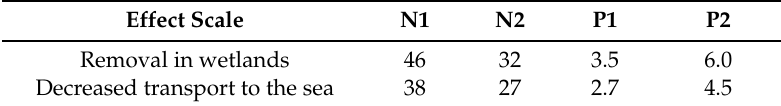
Table 1. The removal effects (kg nitrogen or phosphorus per hectare created wetland area and year) of the wetlands granted support within the Swedish Rural Development Program 2007–2013, according to model calculations on 60 wetlands within the program. The regression models obtained for removal of nitrogen as well as phosphorus in relation to loads for the 15 wetlands with automatic flow proportional sampling and/or strategic grab sampling are designated as N1 and P1, respectively. The multiple regression model based on measurements on sedimentation plates in eight wetlands is designated as P2. The model on the nitrogen removal in relation to load, used in earlier evaluations and based on data from automatic water sampling in six created wetlands, is designated as